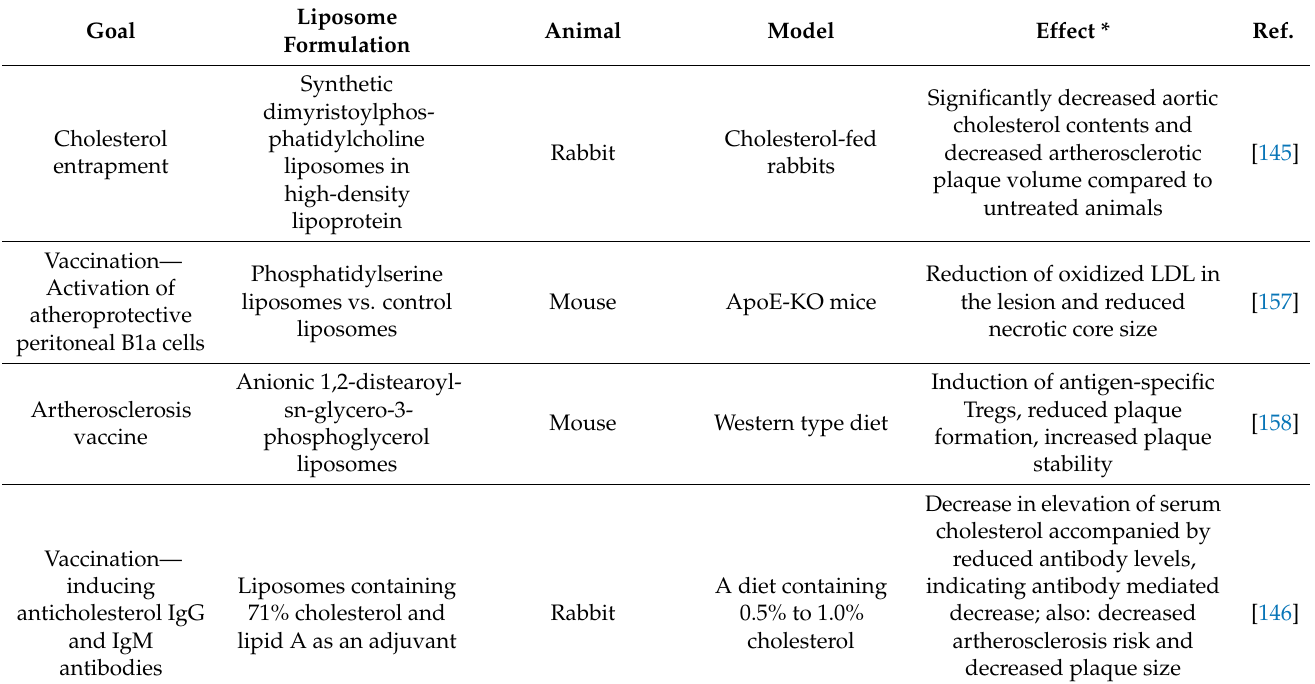
Table 3. Overview of innovative research using liposome-based drug delivery in the treatment of vasculitis, atherosclerosis, and arteriovenous